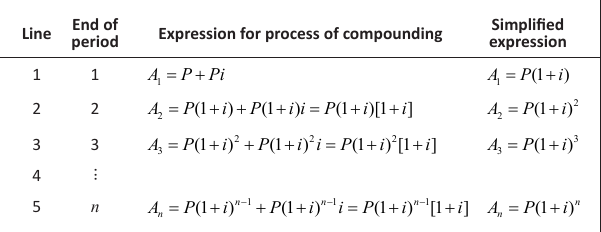
FIGURE 3: An additive approach to deriving the compound interest